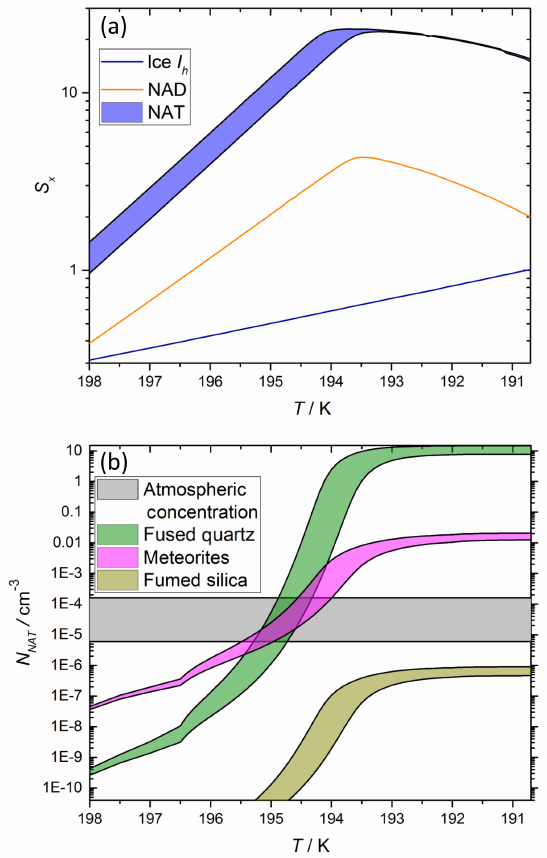
Figure 5. Plot demonstrating that the parameterized nucleating ac- tivities of meteoric materials are able to reproduce typical cloud NAT particle concentrations. Saturations with respect to relevant crystalline phases, S x , are shown in panel (a) and number concen- tration is shown in panel (b) . Equilibrium S x were calculated for air masses at 70hPa (approximately 18km) containing 5ppmv H 2 O, 0.1ppbv H 2 SO 4 and either 10 (minimum of ranges) or 15ppbv (maximum of ranges) HNO 3 using the aerosol inorganic model (Clegg et al., 1998), and number concentrations were calculated using the n s parameterizations shown in Fig. 4, assuming 20 liq- uid droplets cm − 3 air and the availability of meteoric materials de- scribed in Sect. 4 of the